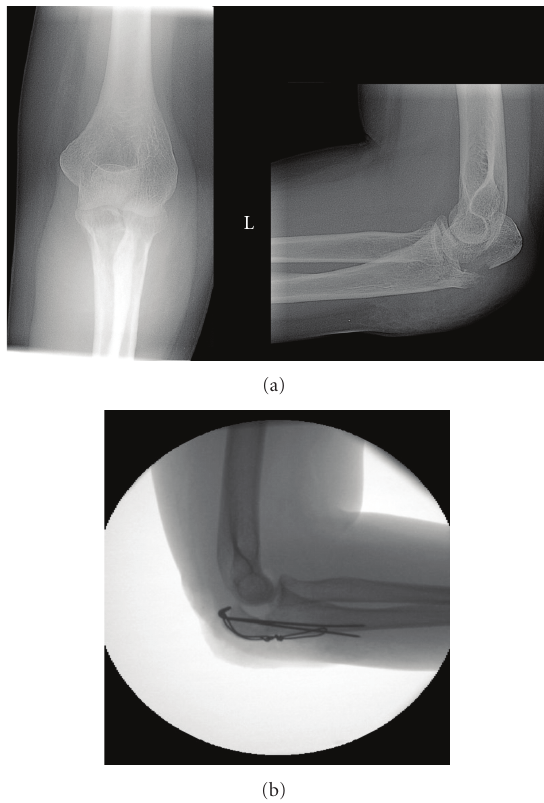
Figure 1: A 24-year-old previously healthy woman fell from standing height directly on her left elbow and sustained an isolated comminuted olecranon fracture (a) She was treated in an outside hospital with a figure-of-eight tension band construct. Intraoperative views with an image intensifier reveal marginal reduction of the fragments and incongruency of the ulnohumeral joint (b).